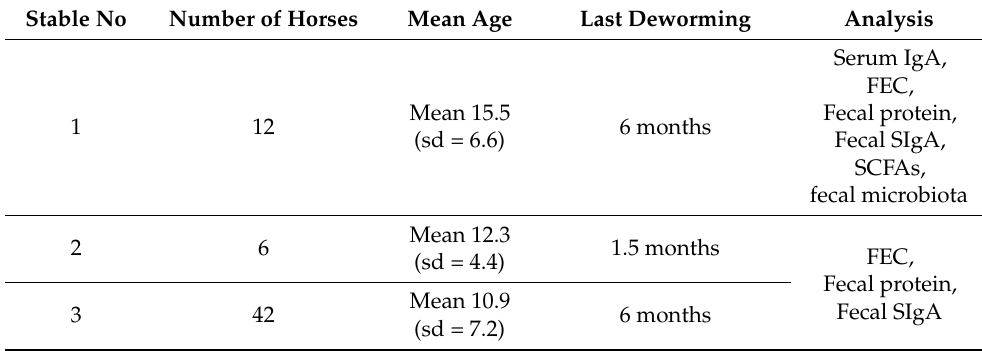
Table 1. Detailed description of stables, horses and